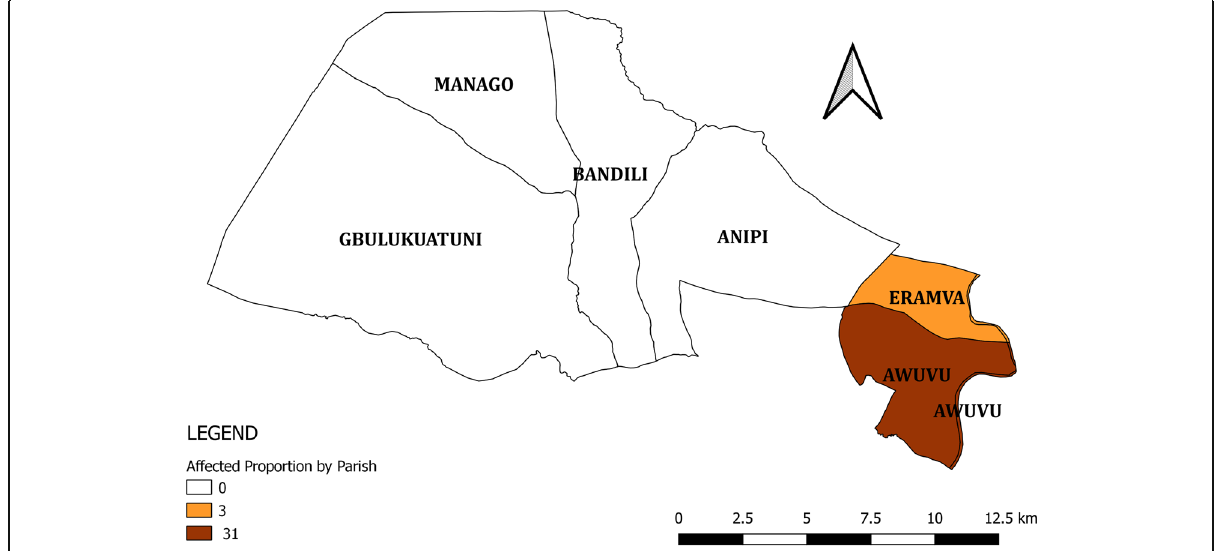
Fig. 2 Parish affected proportions (AP) per10, 000 persons for cutaneous anthrax in Rhino Camp, Arua District, Uganda,